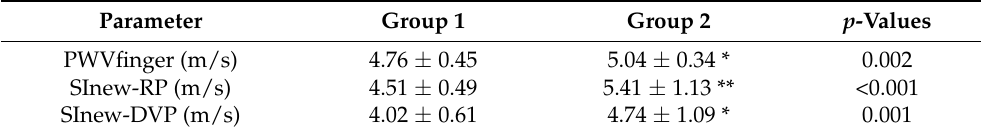
Table 2. Stiffness indices for large arteries (PWV finger , SI new -RP, and SI new -DVP) in Group 1 (healthy middle-aged subjects) and Group 2 (type 2 diabetic